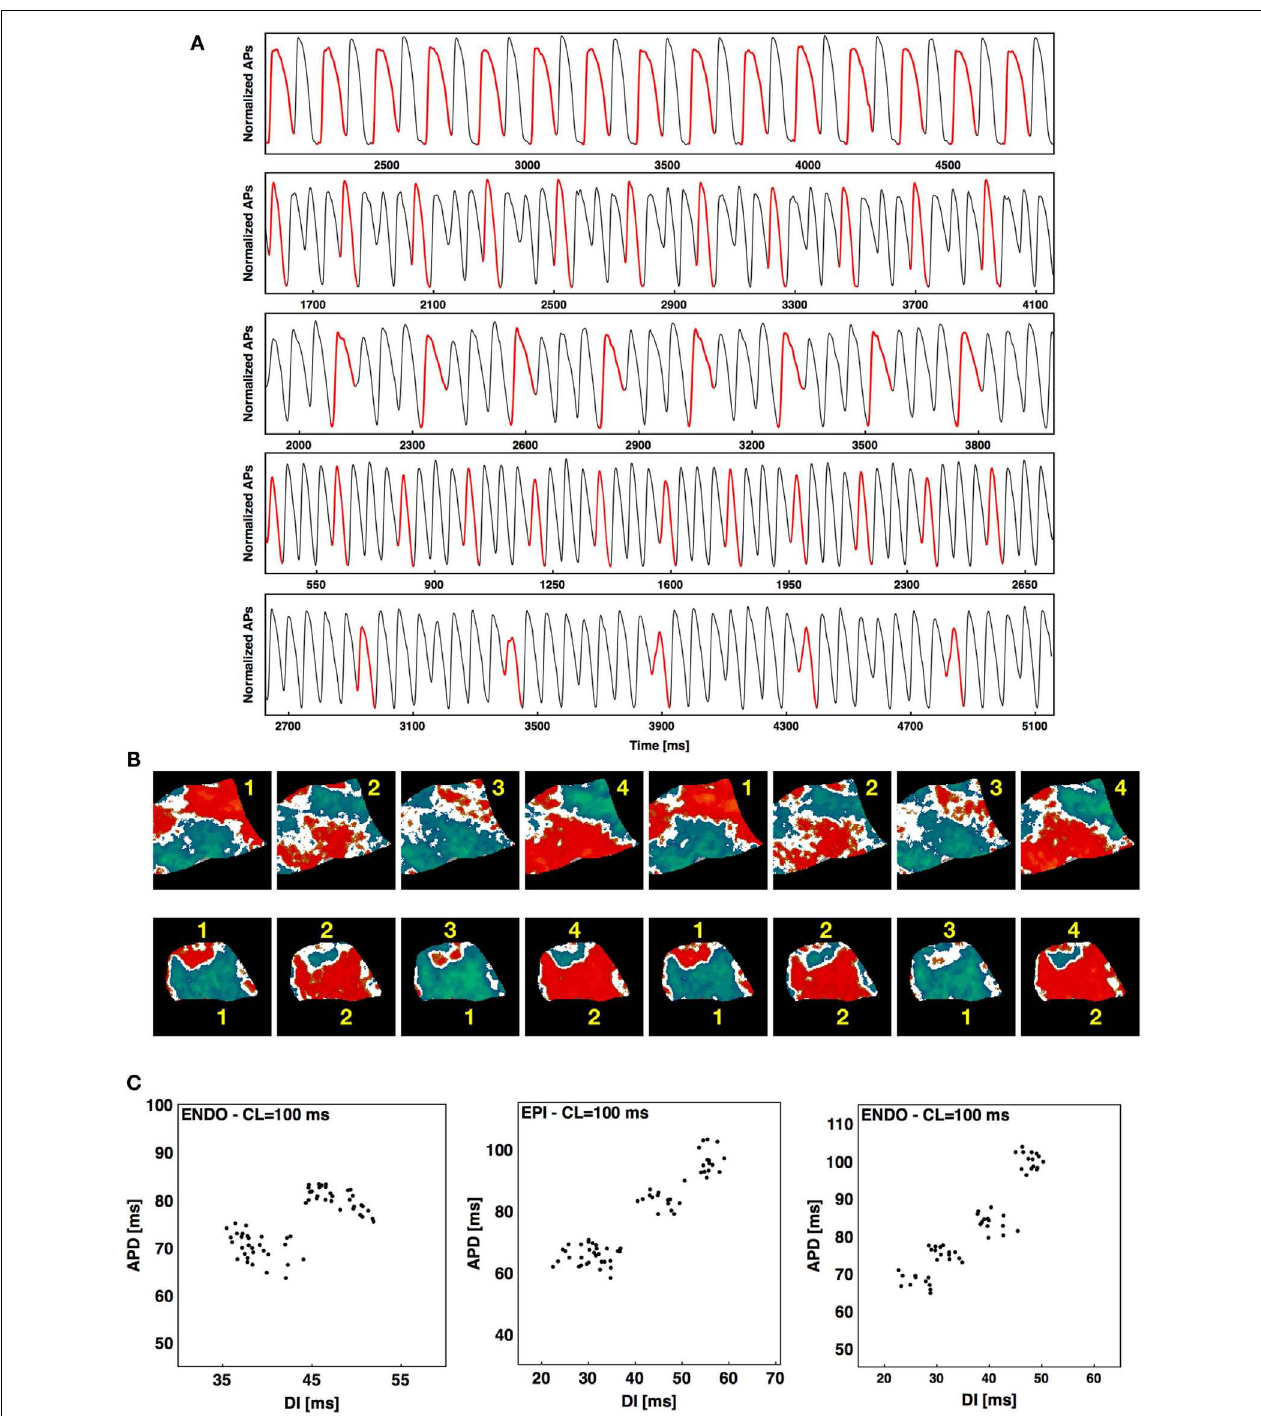
Two consecutive sequences are shown for both cases; see Figure S3 in Supplementary Material for the full sequence. (C) Plots of APD vs. DI from one pixel over time during steady state showing an example of 2:2 rhythm and two examples of 4:4 rhythm, with the first 4:4 a degenerate case. See text and Figure S4 in Supplementary Material for